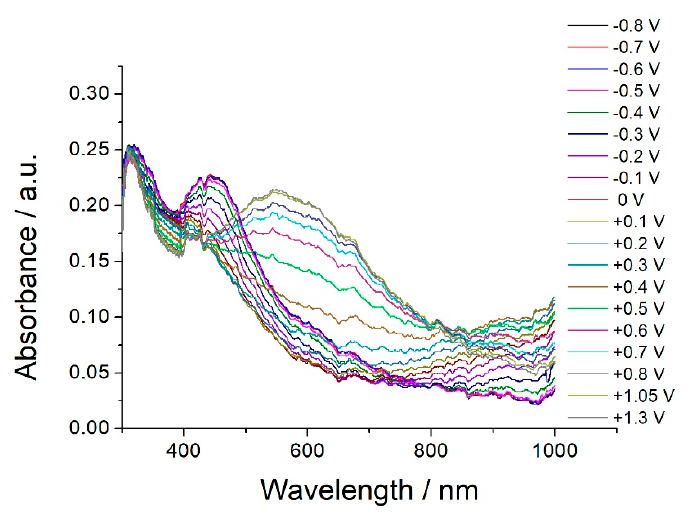
Figure 6. UV-Vis-NIR spectra of a poly-[Co(Amben)]-modified ITO-coated glass electrode acquired during redox switching in 0.1 M Et 4 NBF 4 /EC/DEC.